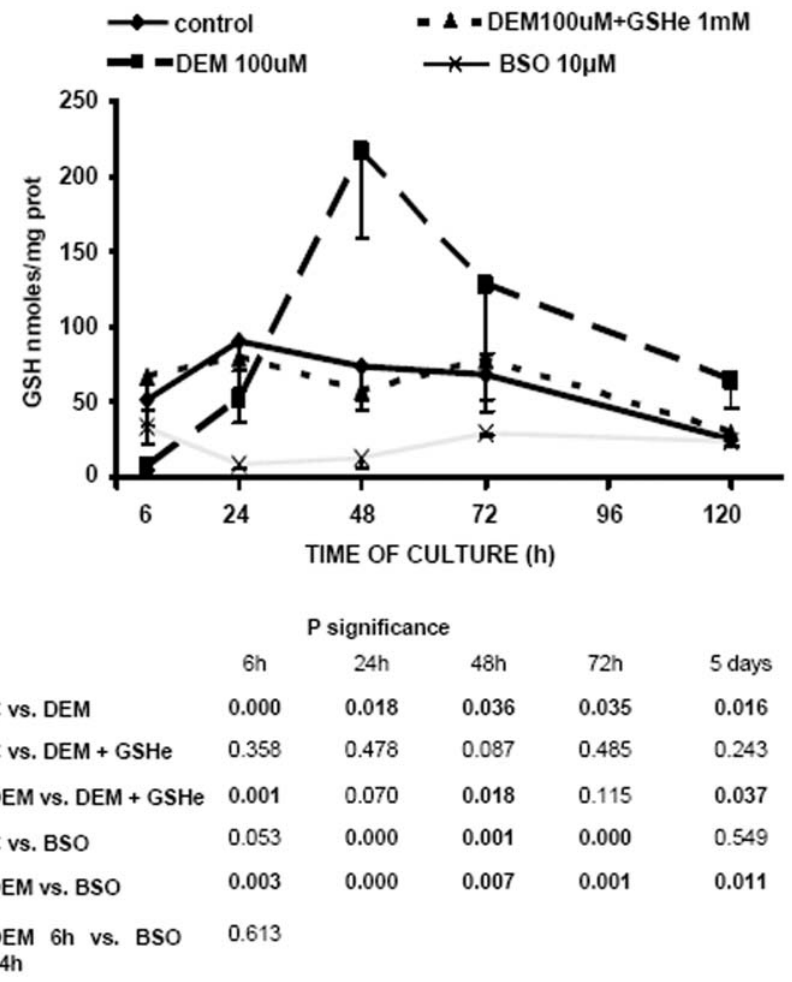
Figure 2. GSH depletion in 3T3 fibroblasts. The total cellular GSH concentration was assessed. The cells were plated as described previously (4) and after attaching 100 m M DEM, or 10 mM BSO, or 100 m M DEM + 1 mM GSHe were added. The total cellular concentration of GSH was determined spectrophotometrically as described in ‘‘Materials and Methods’’. The results are presented as mean 6 SD of 5–12 different experiments.